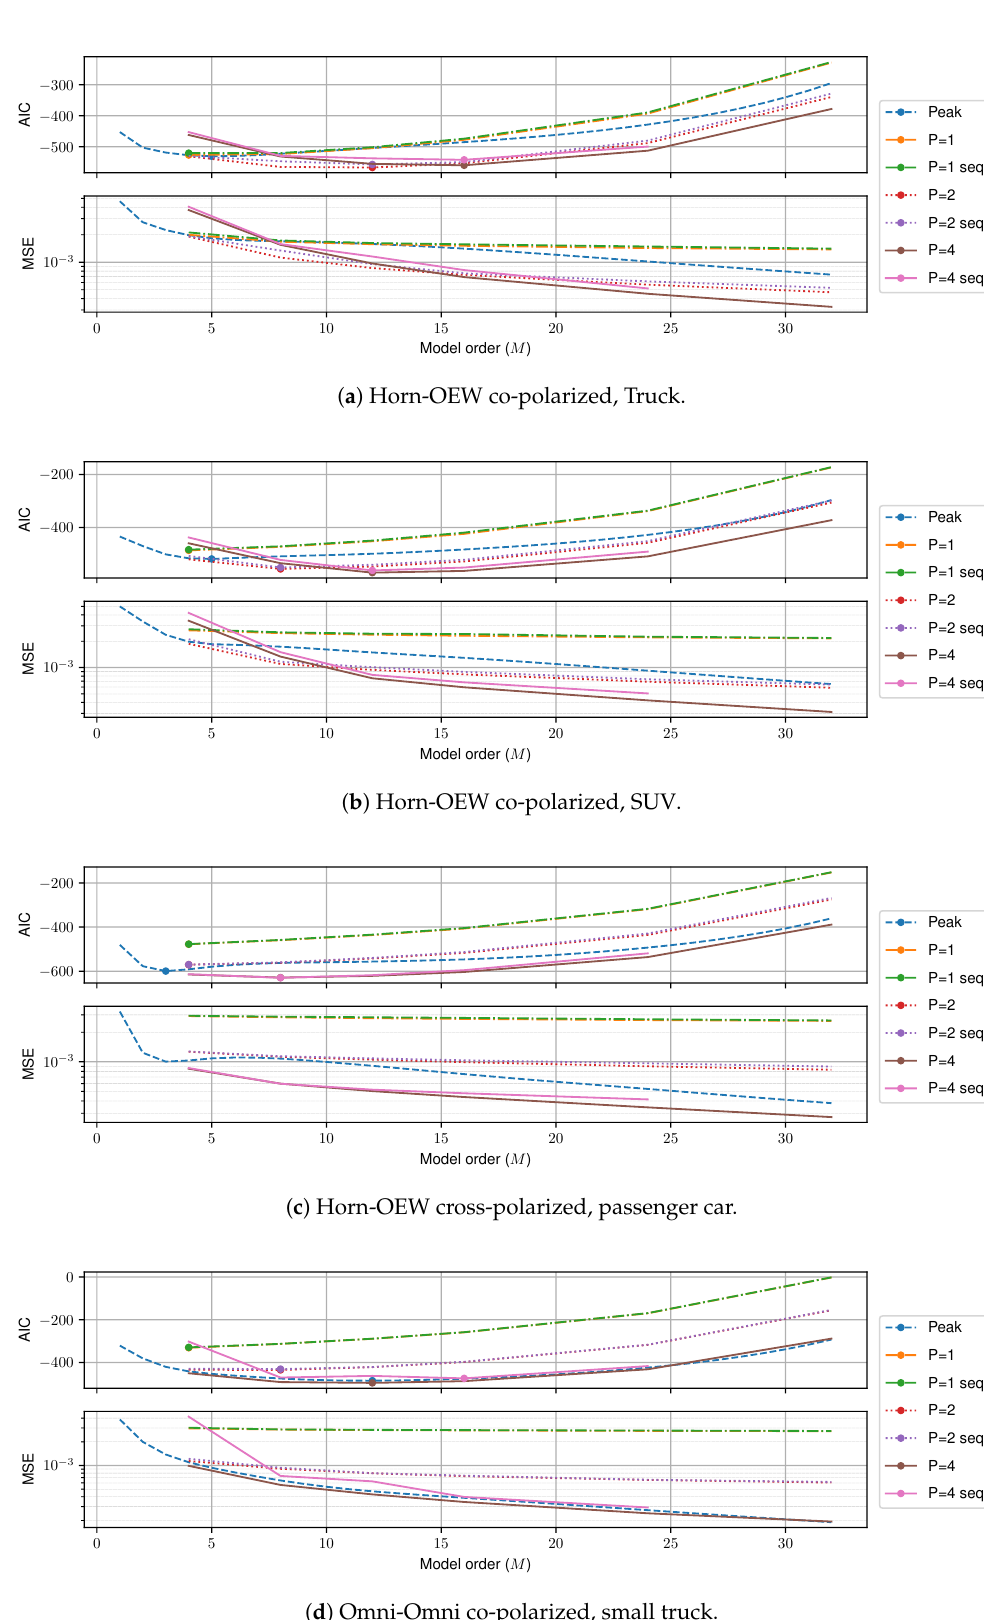
Figure 10. MSE and AIC of the analyzed measurements ( a – d